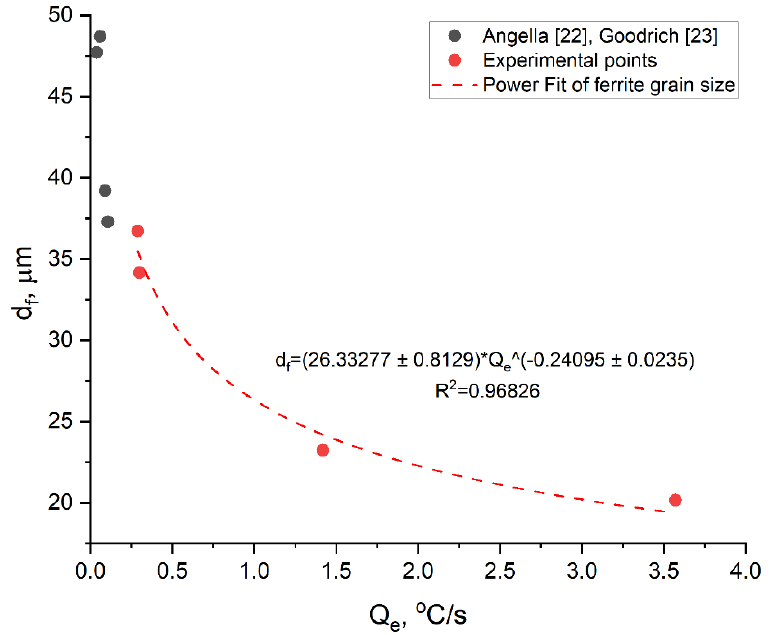
Figure 9. Ferrite grain size as function of cooling rate at beginning of eutectoid temperature T e .